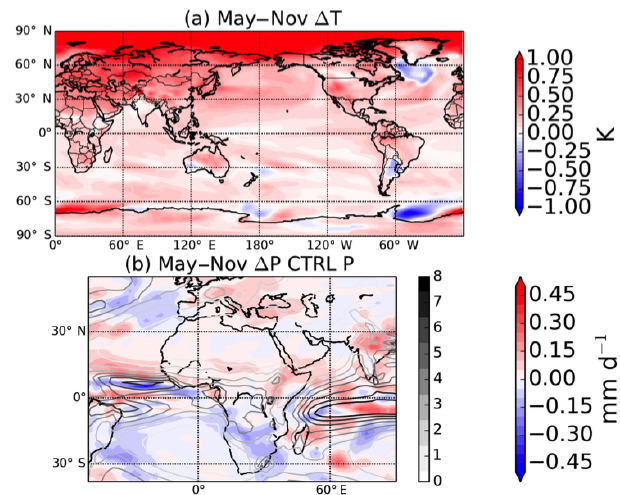
Figure 3. Climate response in GFDL-CM3 to the removal of Euro- pean sulfur dioxide emissions. (a) Change in May–November mean surface temperature over a 200-year simulation (b) Change in mean May–November precipitation (colors). Control precipitation values shown in